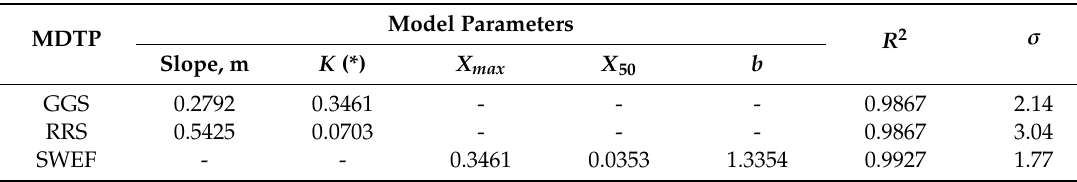
Table 1. Studied model parameters, mill discharge.